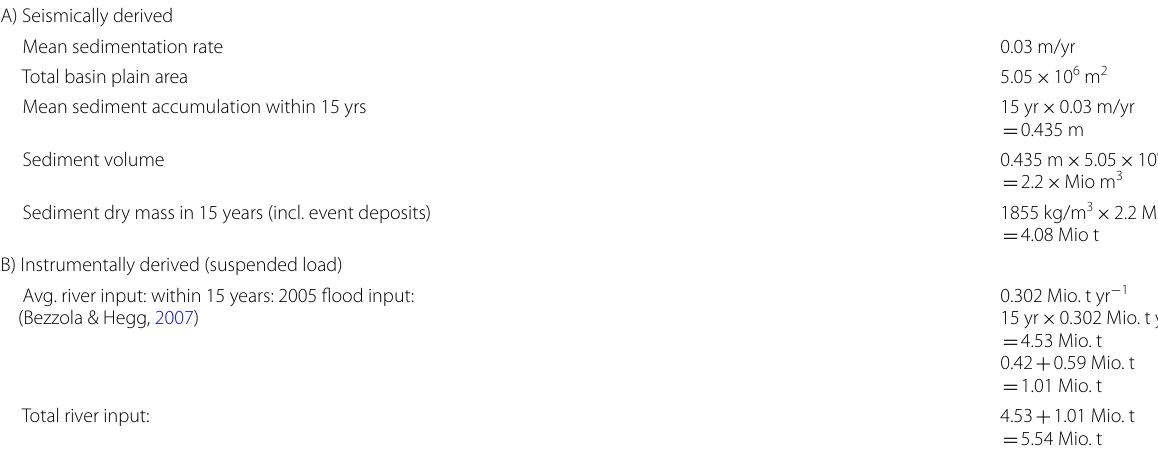
Table 3 Accumulated sediment in the basin plain within the last 15 years derived from seismic (A) and gauging data